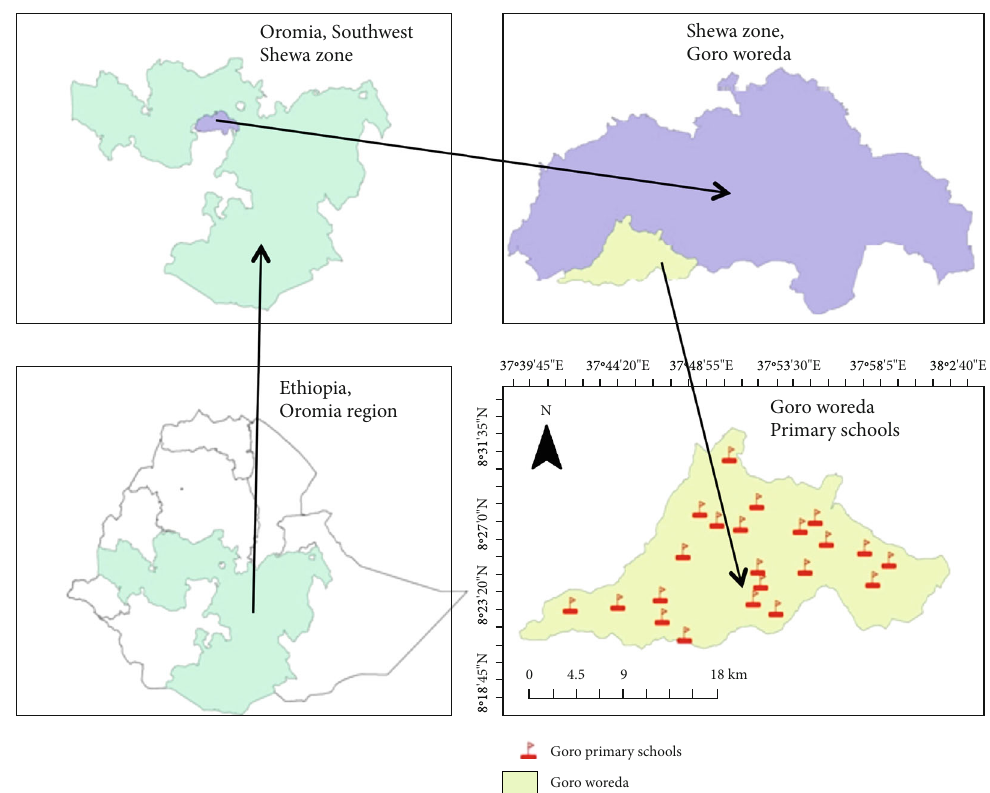
Figure 1: Map of the study